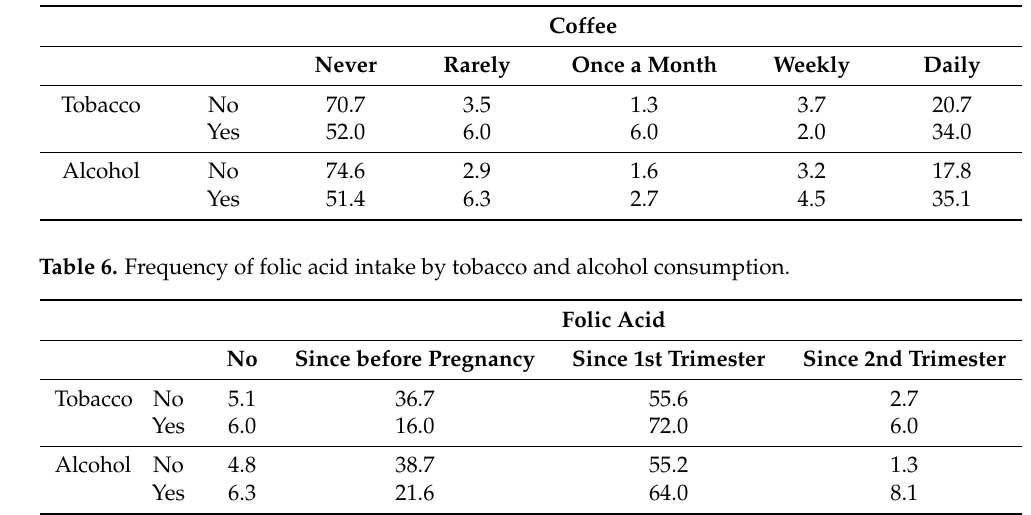
Table 5. Frequency of coffee intake by tobacco and alcohol consumption.